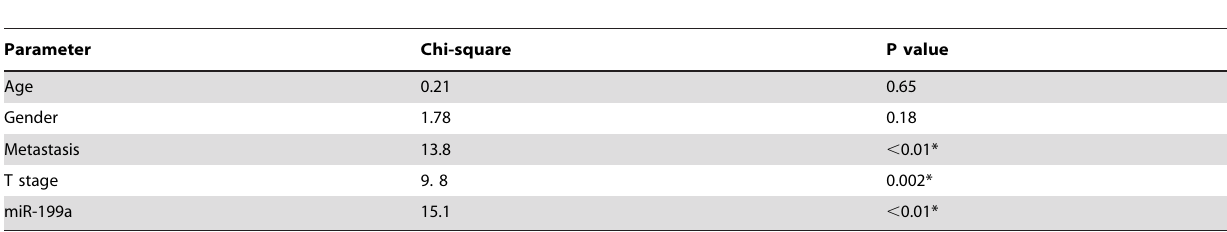
Table 4. Univariate analysis of clinical parameters associated with prognosis.